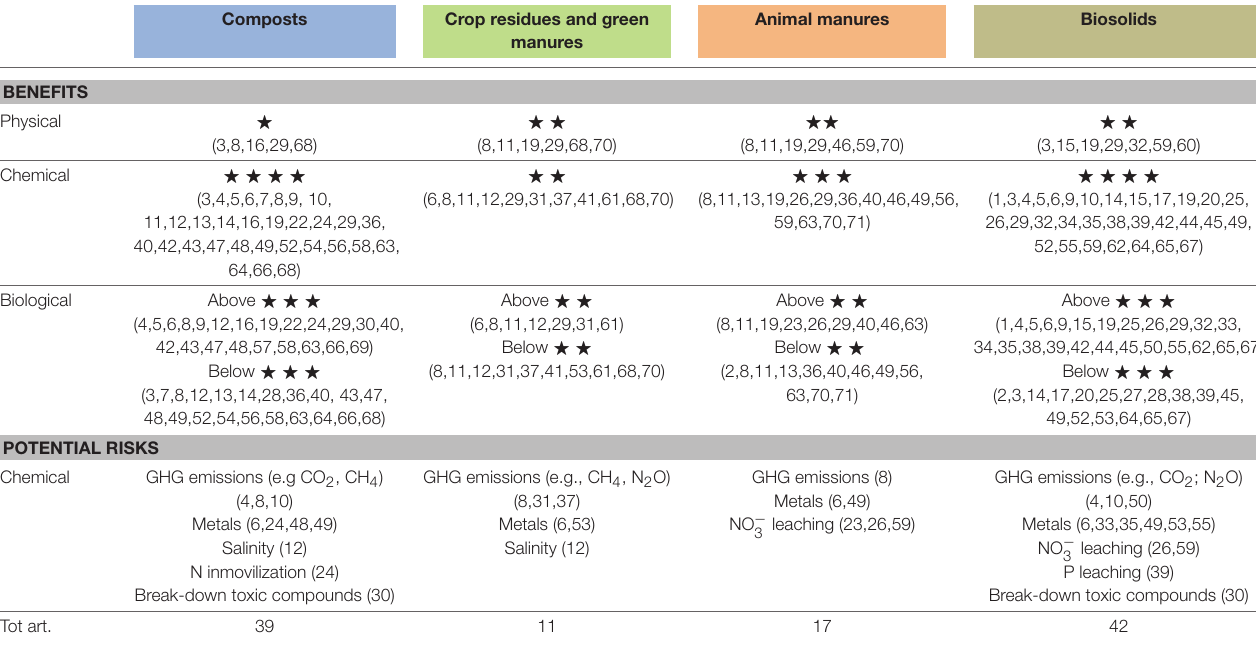
TABLE 1 | Potential benefits and risks on the soil health dimensions (physical, chemical, and biological) resulted from the currently used organic amendments (2013–2018). Composts Crop residues and green Animal manures manures